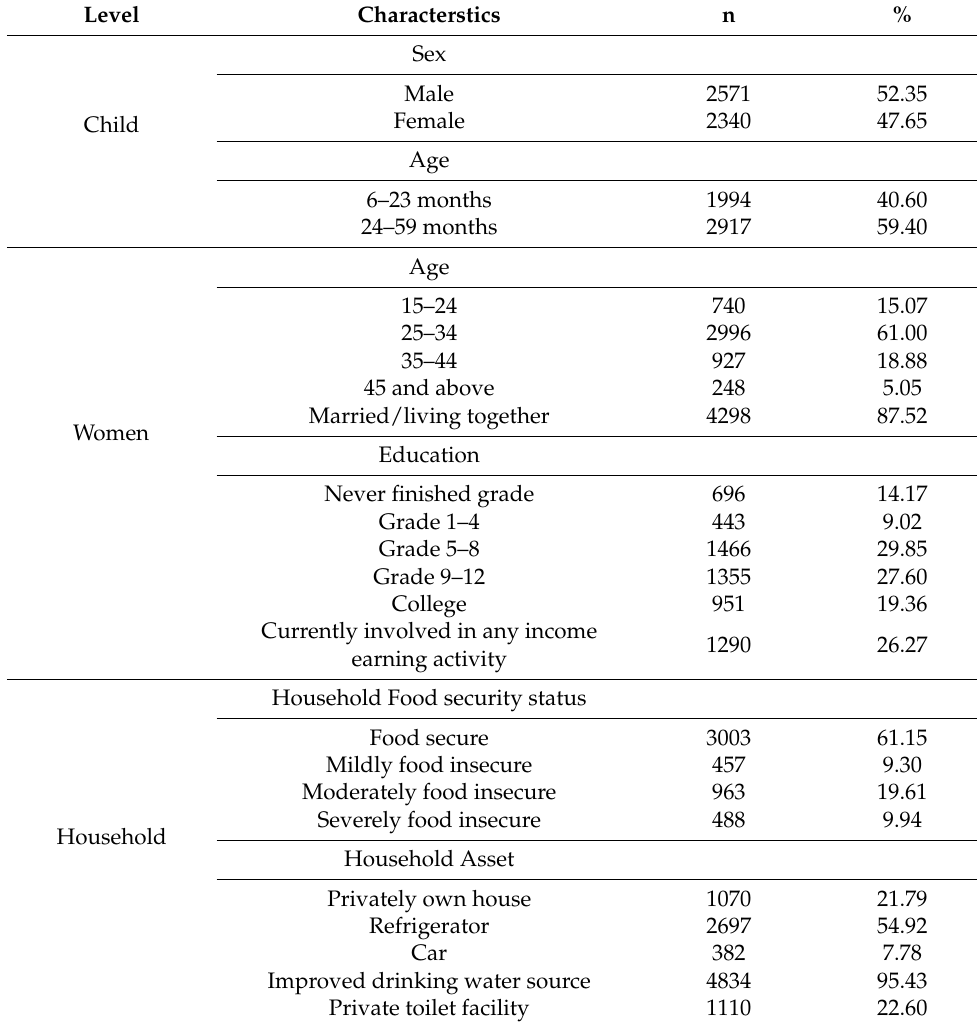
Table 1. Characteristics of household, mothers, and children (6–59months) (n = 4911) in Addis Ababa.